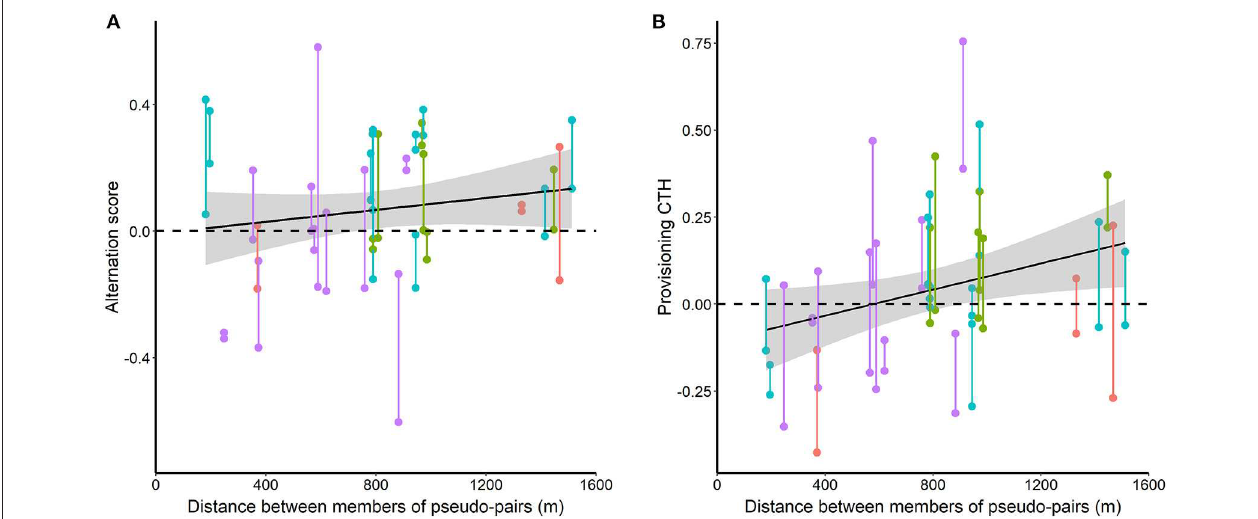
FIGURE 7 | Alternation score (A) and provisioning CTH (B) in pseudo-pairs in relation to the distance between the members of pseudo-pairs. Vertical bars join data for the two reciprocal pseudo-pairs for each pair of nests (the male of each nest pseudo-paired to the female of the other nest). Red, green, cyan and mauve points and lines indicate data collected each day from 10 to 13 May 2014, respectively. The shaded gray areas are the standard errors for the relationship with distance from a linear mixed